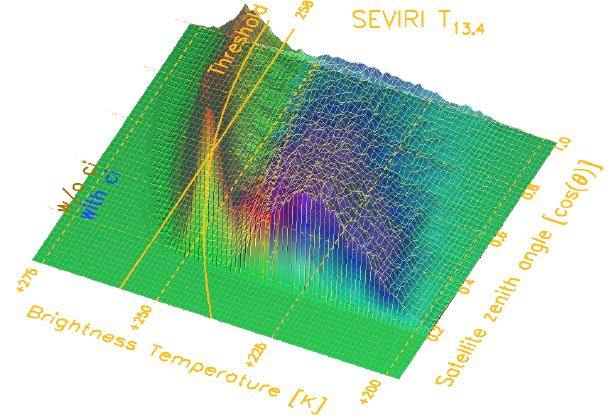
Fig. 3. 2D-histogram of simulated BT of the SEVIRI channel cen- tred at 13.4µm as a function of the cosine of the satellite zenith angle µ =cos θ . In addition, the fixed threshold used in MeCiDA Test 6 of 258K is plotted together with the new µ dependent thresh- old